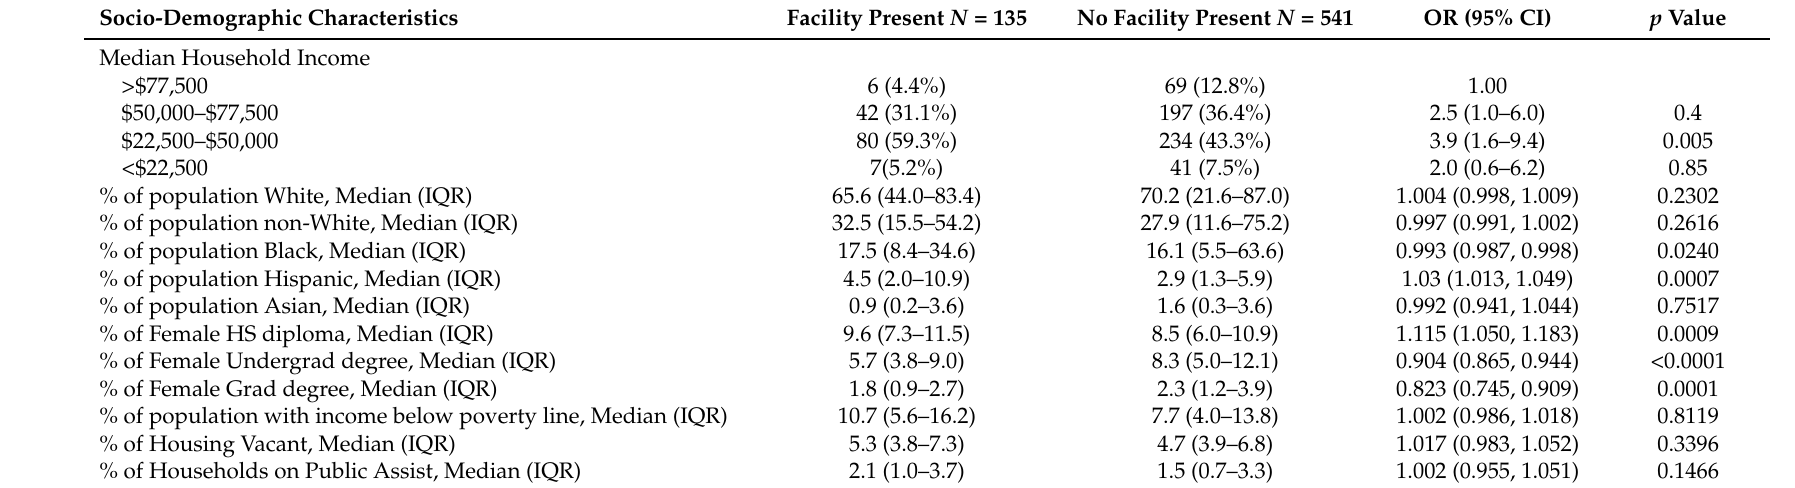
Table 3. Bivariate associations of Toxic Release Inventory (TRI) facility